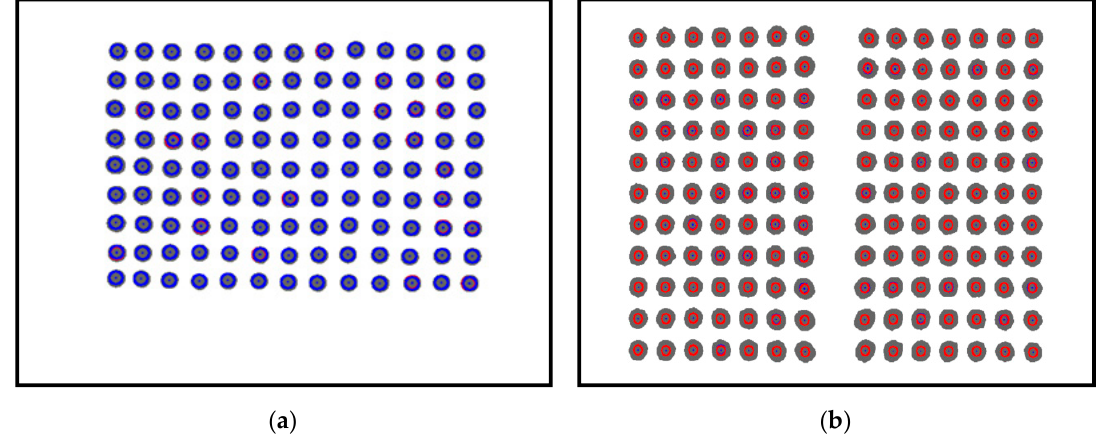
Figure 4. The result of image processing ( a ) single-camera model and ( b ) dual-camera model.